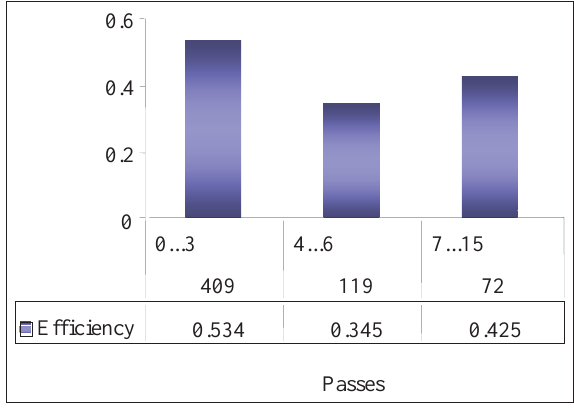
Figure 7. Passes in the off ensive